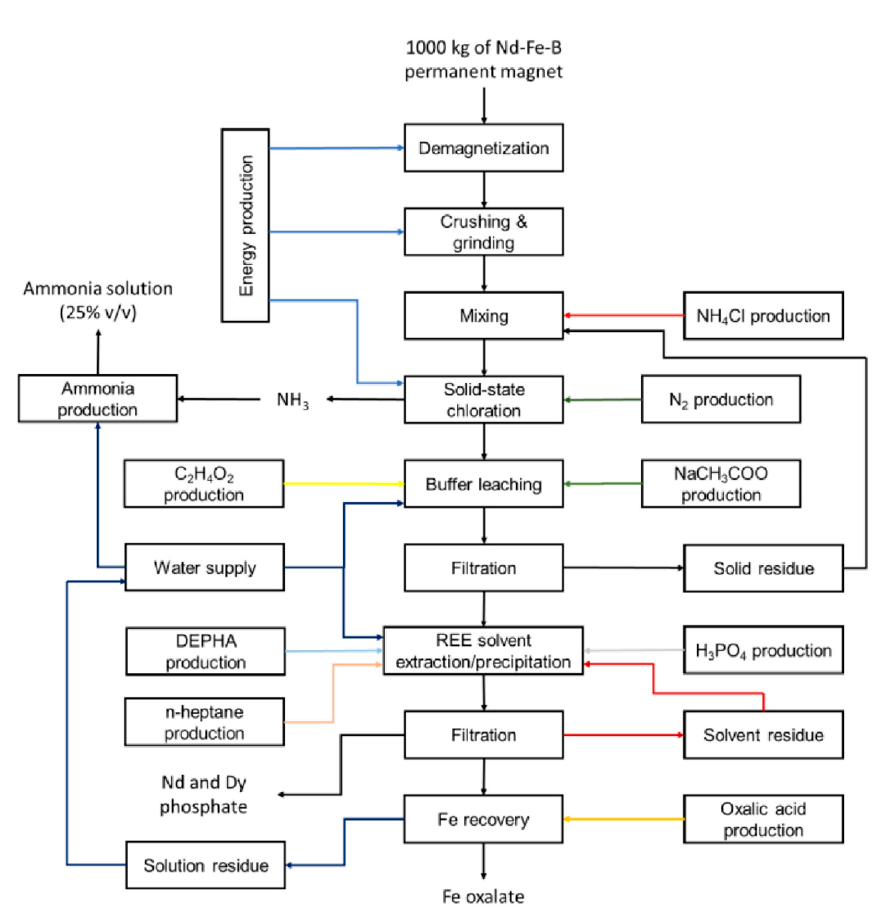
Figure 3. Block diagram of solid-state chlorination process [10,11].